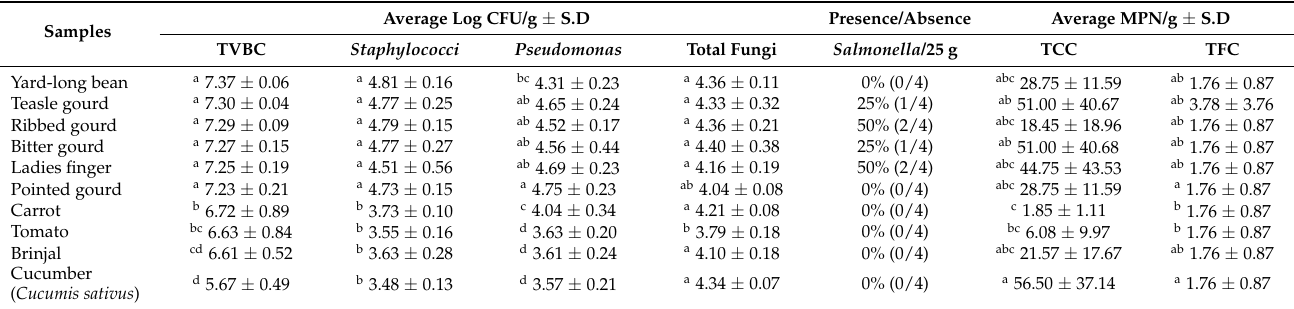
Mean values followed by different letters within a column of tested samples were found to be significantly different using a post hoc multiple comparisons test ( p < 0.05). MPN = most probable number; CFU = colony-forming unit; TVBC = total viable bacterial count; TCC = total coliform count; TFC = total fecal coliform; “ × ” = not detected. Data are mean ( n = 4) ± standard